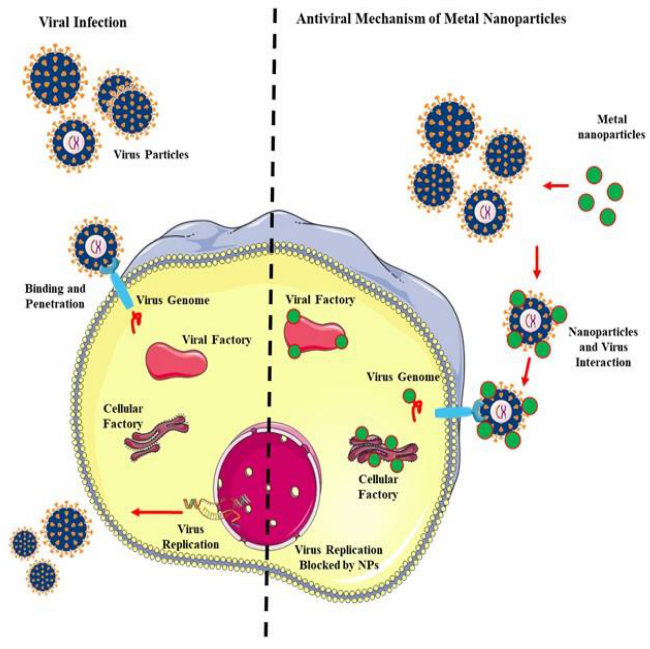
Figure 3. Antiviral mechanism of nanoparticles (NPs).